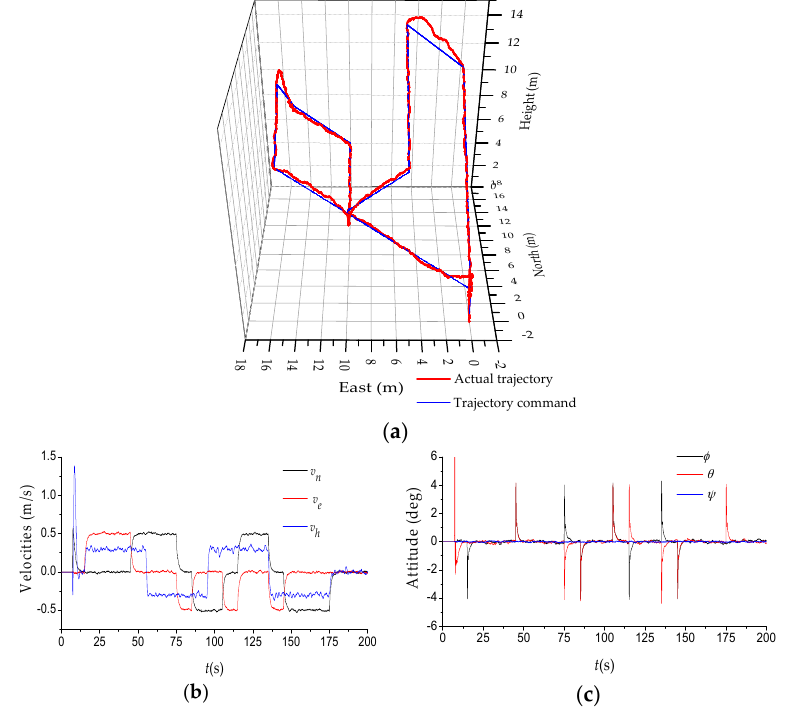
Figure 11. The experimental results of the proposed method during near-hover operations: ( a ) 3D flight trajectory tracking; ( b ) flight velocities; and ( c ) attitude.